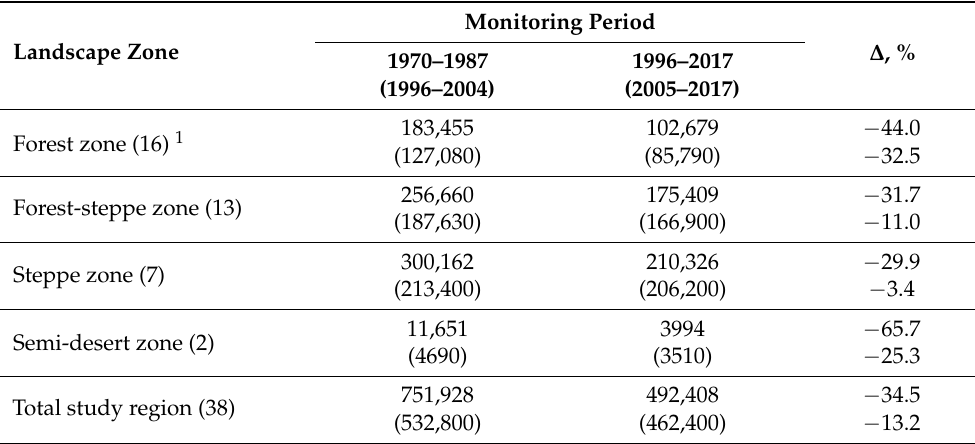
Figure 3. Relative reduction ( ∆ R) in cultivated land area within the analyzed administrative regions of European Russia between 1970–1987 and 1996–2017, according to [64]. Note. The boundaries of the landscape zones are given, according to [67]. For other symbols, see Figure 2. Table 2. Changes in the total area (km 2 ) of cultivated land within the analyzed landscape zones of European Russia (see Figures 2 and 3) during 1970–2017.